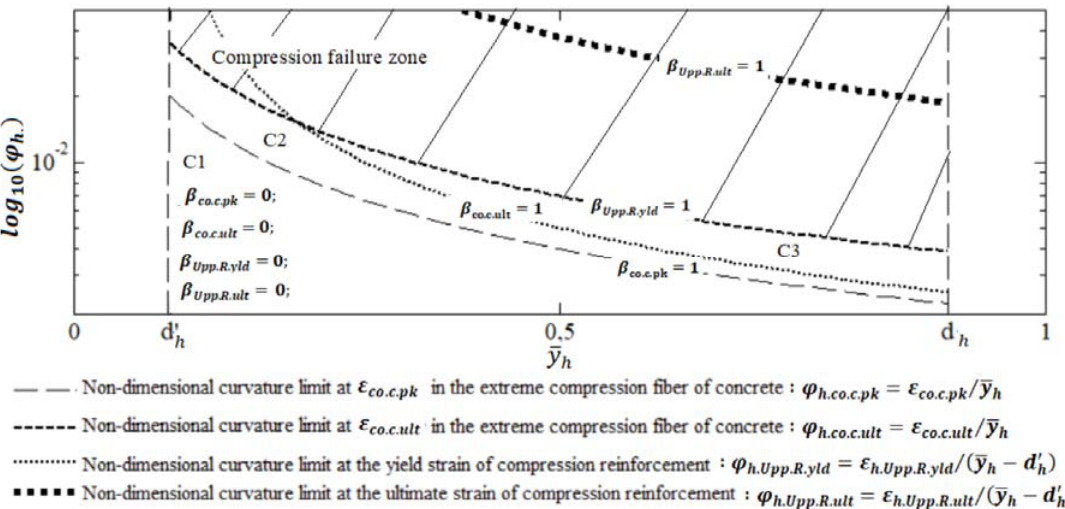
Figure 12. Curvature limits for compressive stress block.